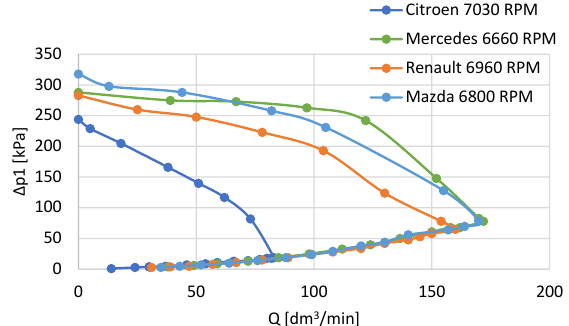
Fig. 8. Working areas of individual CPs – pressure as a function of volu- metric flow rate